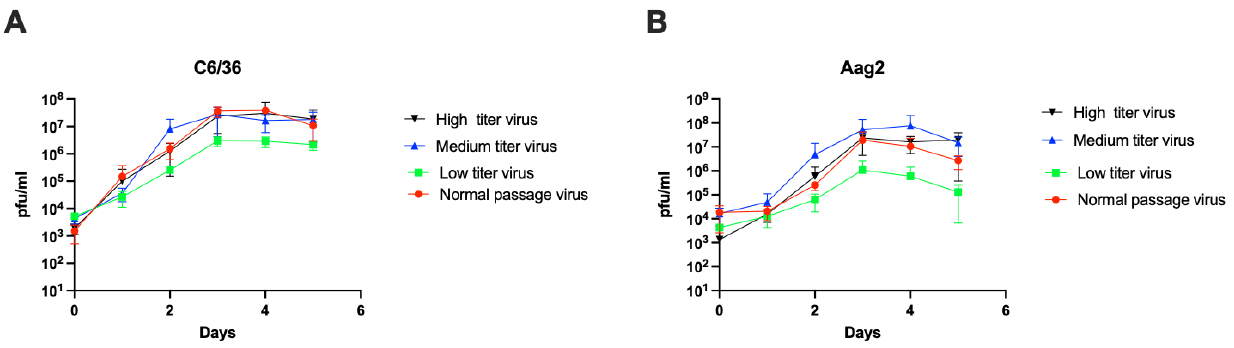
Figure 6. Growth curves of viruses obtained from high, medium, and low titer mosquitoes compared to normally passaged MRE-16 stock virus in ( A ) C6/36 cells and ( B ) Aag2 cells as determined by TCID 50 assay. Viruses from pools of 5 mosquitoes were used in this experiment. The bars indicate the means ± standard error of four independent biological replicates (four pools of mosquitoes per treatment). Results were analyzed by two-way ANOVA for C6/36 ( p = 0.0058) and Aag2 ( p = 0.0653).